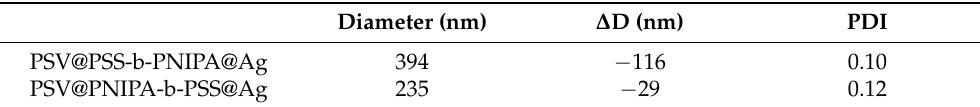
Table 2. Diameter and PDI of 9eblock polymer brushes loading AgNPs. Diameter